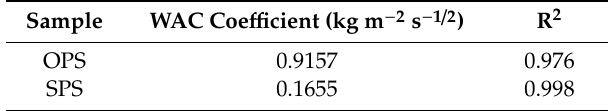
Figure 5. Ornamental porous stone (OPS) (1) and structural porous stone (SPS) (2). Sample ( a ) and picture from an optical microscope ( b ). and picture from an optical microscope ( b ). Table 2. Water absorption by capillarity (WAC) coe ffi cients for